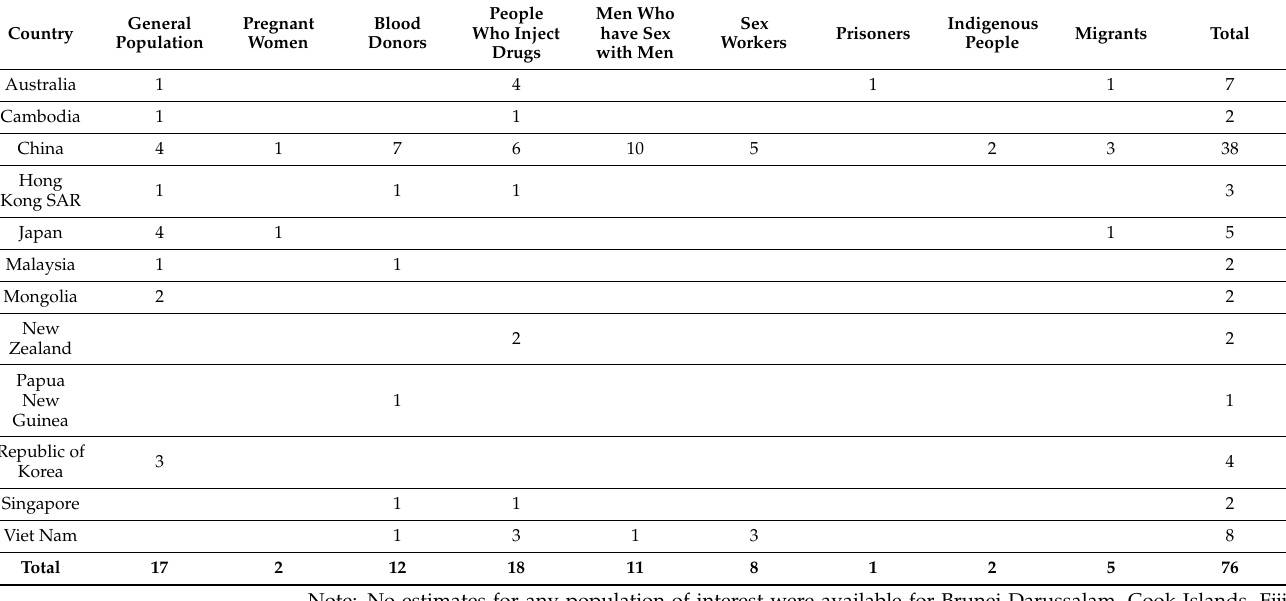
Table 1. Number of identified estimates for the prevalence of hepatitis C (anti-HCV or RNA) from WHO WPR by population category, 2016–2020 (n =